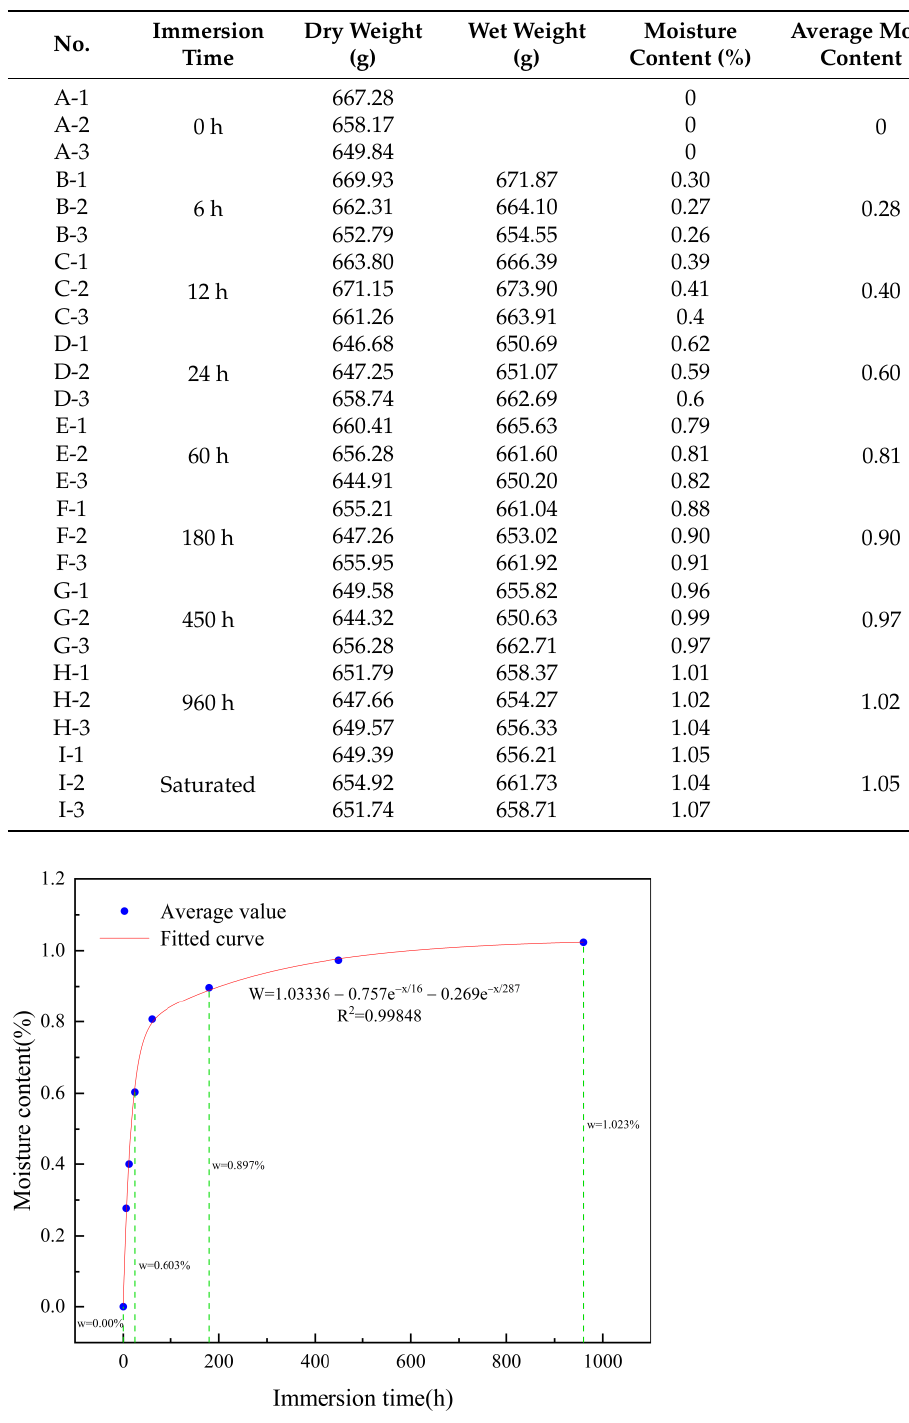
Figure 3. Relationship between moisture content and immersion time.